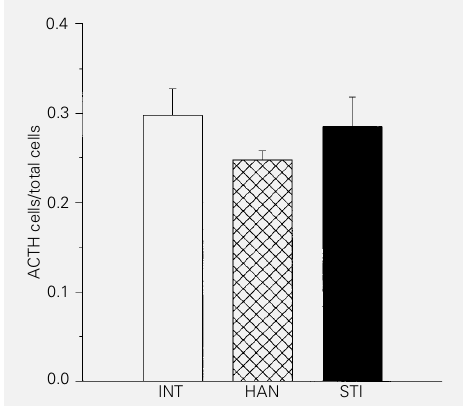
Figure 1 - Relative number of corticotroph cells (number of ACTH-antibody-stained cells di- vided by total number of cells) in the anterior lobe of the pituitary of 11-day-old male rats. The re- sults are reported as means ± SEM for 600 cells/pituitary. Each group represents the average of 5 pituitaries. Intact (INT) control rats suffered no previous ma- nipulation, handled (HAN) rats were gently manipulated for 1 min during the previous 10 days, and stimulated (STI) rats were submitted to cold, direct light or intense sound for 10 min during the same period. No statistically significant difference was ob- served between groups